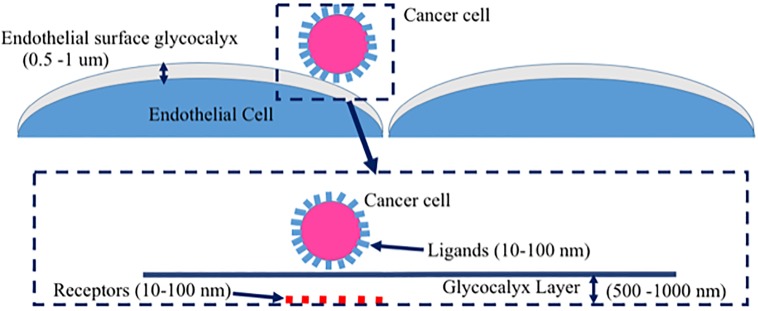
Schematic illustration of a cancer cell circulating in vicinity of endothelial surface glycocalyx.A) Cancer cell in vicinity of endothelial surface glycocalyx. B) Receptors on a substrate and ligands on a membrane. The glycocalyx layer is anchored on the endothelial cell surfaces.